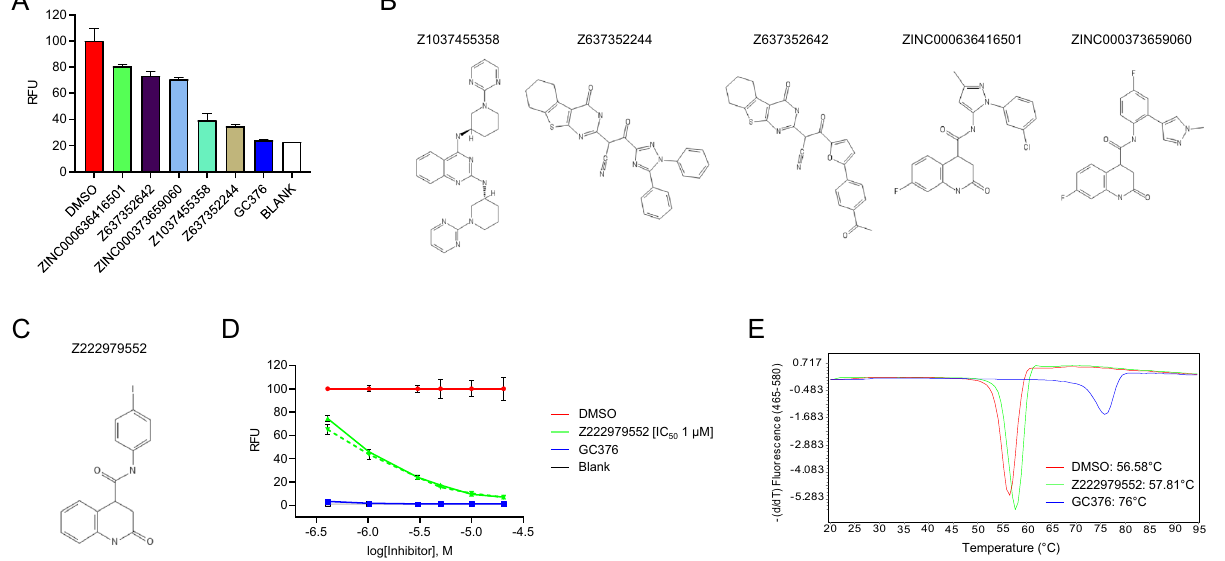
Figure 1. Development of M pro inhibitors from in silico screening hits. ( A ) Graph showing the inhibitory activity of the five validated in silico screening hits tested at a final concentration of 40 μM in an in vitro protease-activity assay. After addition of the FRET substrate, fluorescence was acquired at 10 min intervals over 60 min. For each compound, the increase in fluorescence intensity was normalized to the DMSO control. GC376, a previously described M pro inhibitor, served as a positive control. Blank, reaction omitting M pro ; RFU, relative fluorescence units. ( B ) Chemical structure of the five validated compounds. ( C ) Chemical structure of Z222979552, the most active dihydro-quinolinone compound obtained after two rounds of chemical structure similarity searches of the REAL space library of molecules. ( D ) Dose–response curves for compound Z222979552 examined at 0.4, 1, 3, 5, 10 and 20 μM final compound concentrations, in absence (solid lines) or presence (dashed lines) of 0.1 μg protein lysate. DMSO, GC376 and blank controls are as described above. ( E ) Thermal shift assay performed in the presence of DMSO or 20 μM of compounds Z222979552 or GC376. The graphs show the derivatives of the melting curves used to calculate the melting temperature of M pro